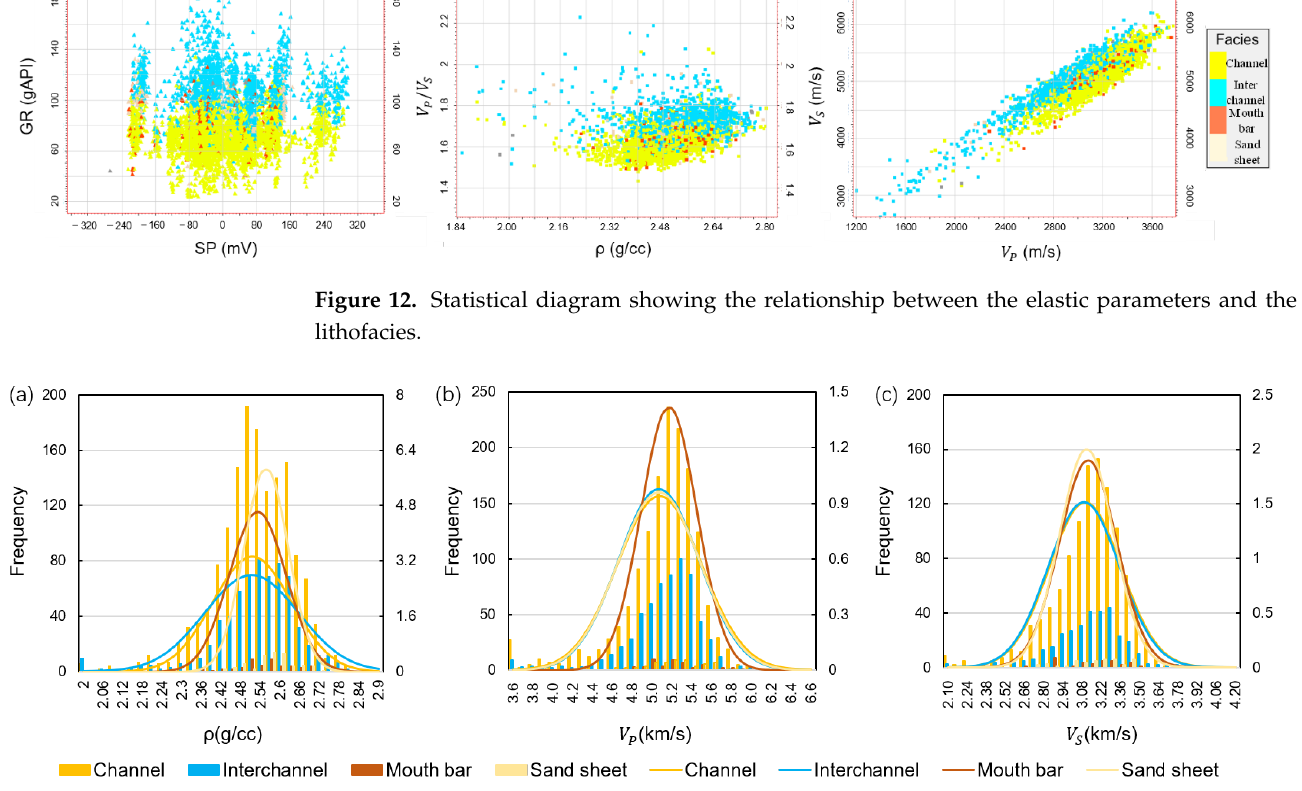
Figure 13. Analysis of the elastic parameters of the different lithofacies in the wells: ( a ) density, ( b ) p-wave velocity, and ( c ) shear wave velocity.